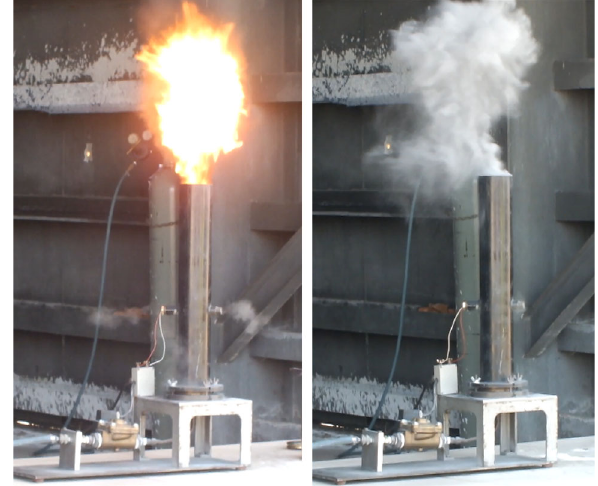
Fig. 4 Coal dust explosion tests of one teaspoon of coal dust without ( left ) and with ( right ) four spoon of rock dust (80% rock